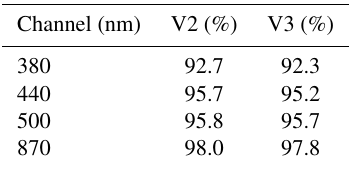
Table 3. Percentage of AERONET-Cimel (V2 and V3) 1min AOD data meeting the WMO criteria for the four interpolated GAW-PFR channels for the period